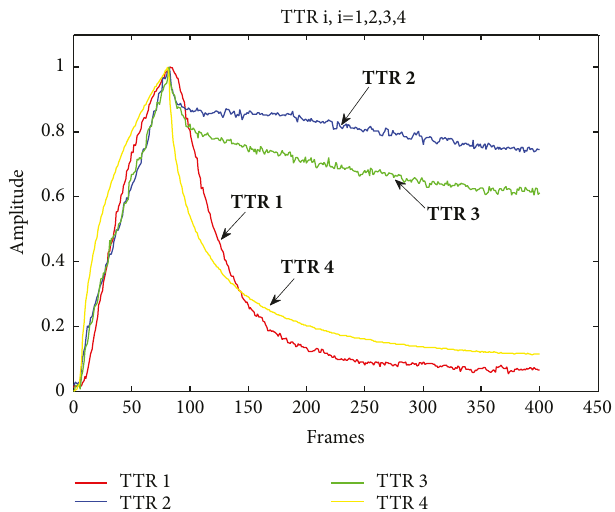
Figure 12: The comparison of 𝑇𝑇𝑅 1 , 𝑇𝑇𝑅 2 , 𝑇𝑇𝑅 3 , and 𝑇𝑇𝑅 4 of sample